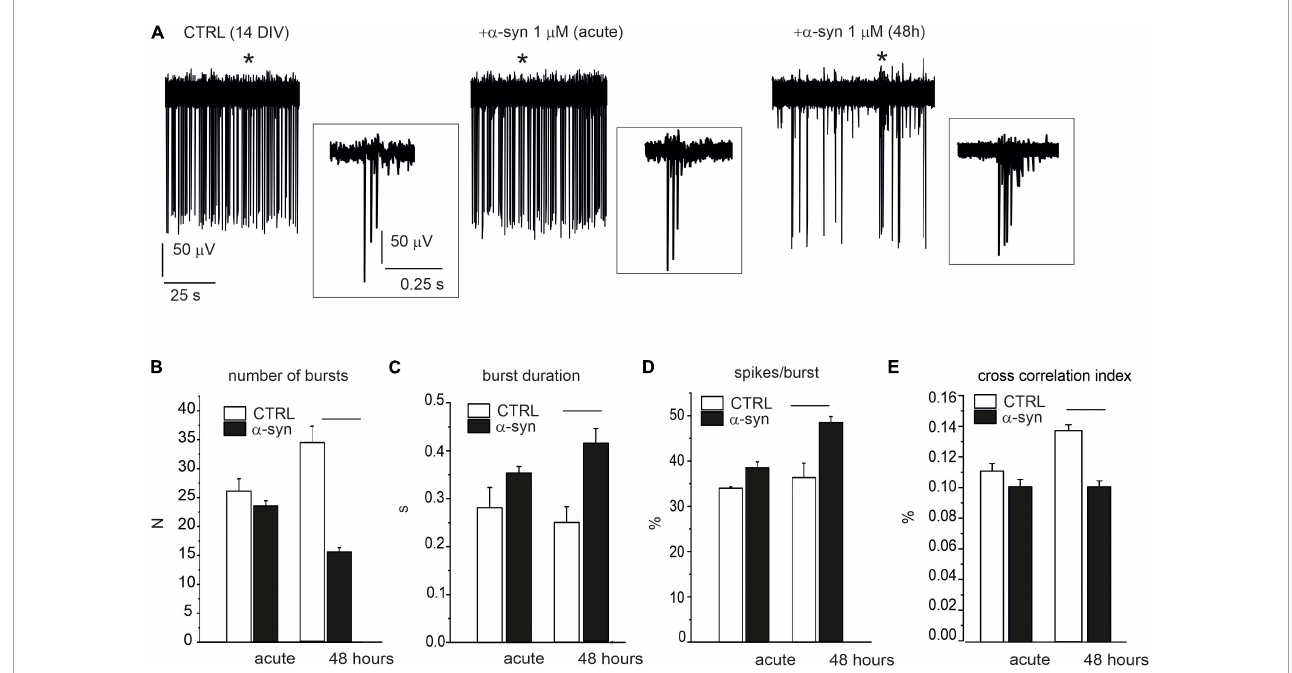
FIGURE10 Impaired burst activity by α -syn (14 DIV neurons). (A) Single electrode recordings from one representative microelectrode arrays (MEA) under control conditions (without α -syn), immediately after α -syn addition (acute) and after 48 h exposure. Asterisks indicate the bursts that are shown in the insets at higher magnification scale. Part of the recording (120 s) has been shown. (B–D) Bar plots compare data without α -syn (CTRL), after acute addition of α -syn and after 48 h exposure. (B) Mean number of bursts (during 120 s recordings) ( p < 0.0001). (C) Mean burst duration ( p < 0.0001). (D) Mean percentage of spikes within bursts during 120 s recordings ( p < 0.0001). (E) Mean cross-correlation histograms (CCH) peak amplitude ( p <